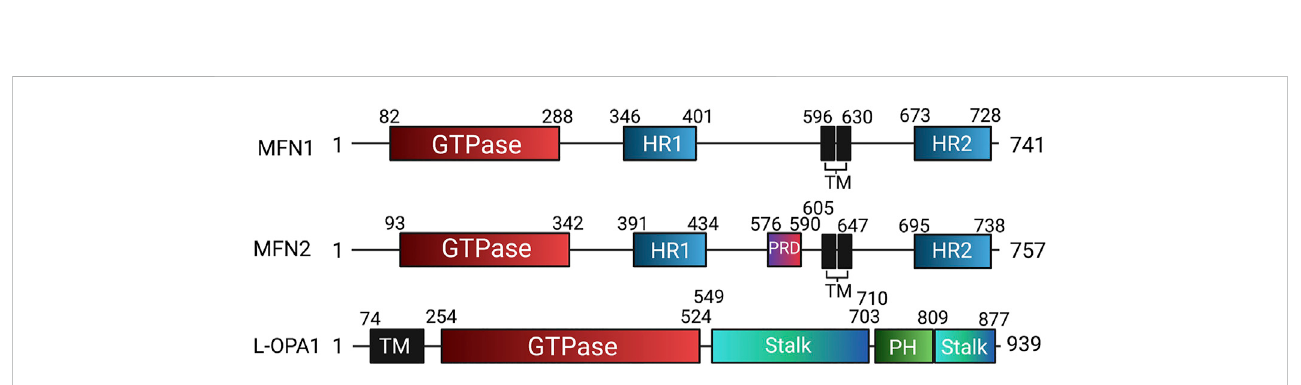
FIGURE 7 Domain organization of human mitochondrial fusion mediators. Human mitofusin 1 (MFN1), mitofusin 2 (MFN2), and long optic atrophy 1 (L-OPA1) with annotateddomainboundaries.Abbreviations:GED — GTPaseeffectordomain;HR-Heptadrepeat;HRN-N-terminaltruncatedheptadrepeat,PH-Pleckstrin homology; PRD — Proline rich domain; TM -